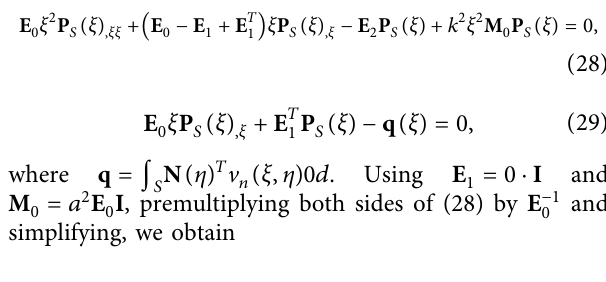
Figure 14: Vibration mode shapes in a vacuum and in water with H � 8m, G � 50MPa, l (c)